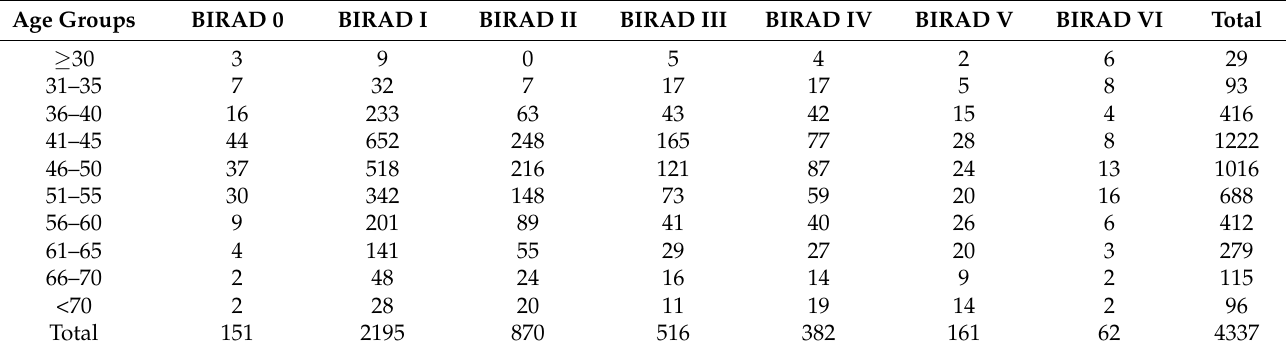
Table 7. The age group-wise distribution of BIRADs.